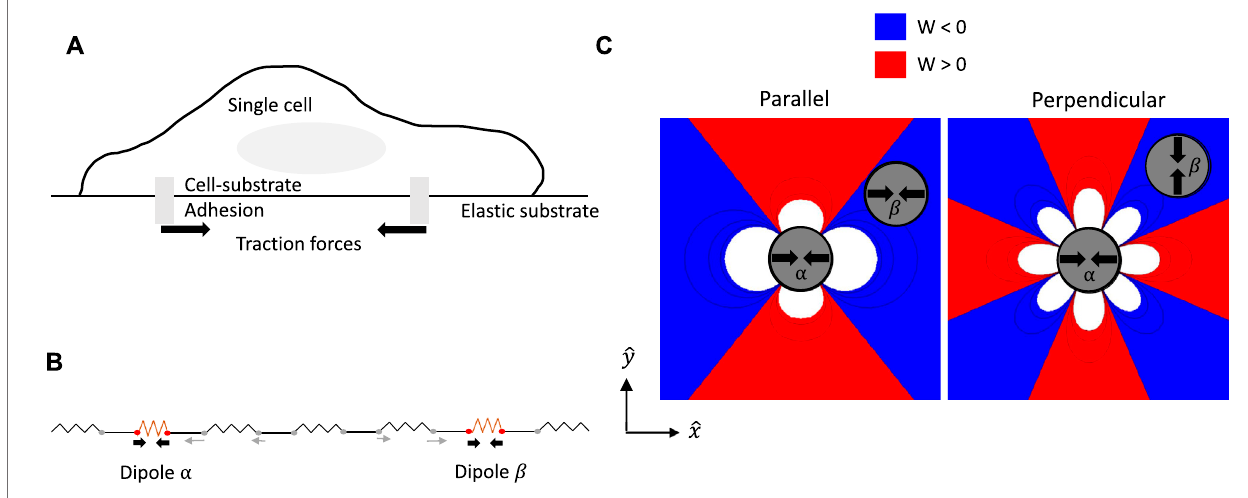
FIGURE1| Elastic interactions betweenmodel cellsonasubstrate. (A) Schematicofadherentcell onanelasticsubstrate. (B) 1Dspringmodelillustrating originof elasticinteractionpotentialbetweentwocontractiledipoles.Theelasticenergystoredinthemediumcorrespondingtothedeformationofspringsdependsontherelative placement of the dipoles. In particular, placing a contractile dipole in a region where the medium is already expanded by the other dipole can help to reduce the overall deformation of the medium. This leads to a strain-dependent interaction potential between the two dipoles. (C) Representative spatial maps of the interaction potential W αβ between two dipoles, from the solution of the strain fi eld for the full linear elastic problem of forces exerted on the surface of a semi-in fi nite medium are shown. The interaction potential corresponds to the work done by a point-like dipole in deforming the substrate in the presence of the strain created by the other. The potentialmapsshownhereareforapairofcontractileforcedipolesof fi xedorientation.Theseconddipoleisfreetotranslatebutheldparallel(left)orperpendicular(right) to the central dipole which is placed at the origin and aligned along the x -axis. The contour lines show how the potential decays in space, whereas blue and red regions correspond to attractive ( W αβ < 0) and repulsive ( W αβ > 0) interactions,